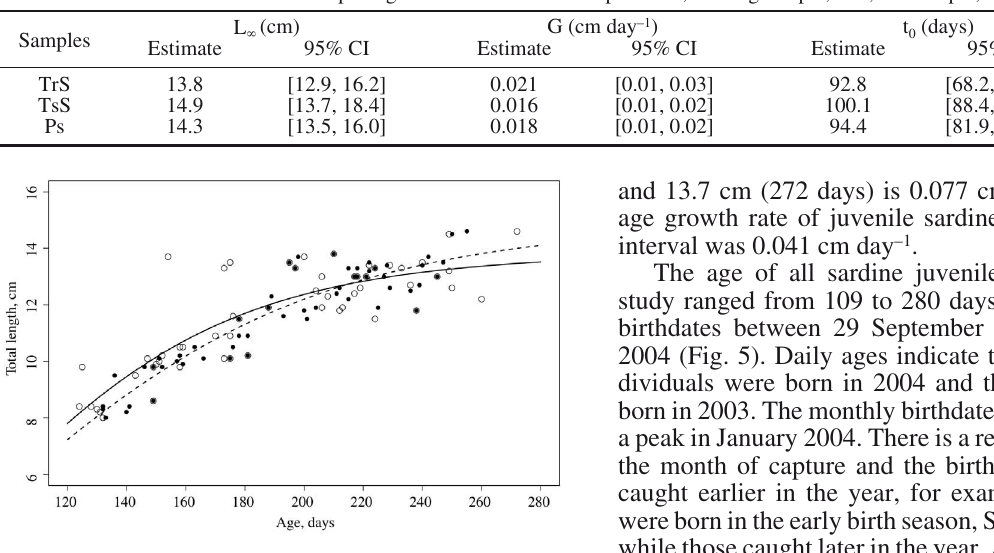
Fig. 4. – Gompertz growth curves of juvenile sardine based on ob- served ages (open circles and solid line) and model-predicted ages (full circles and dashed line).